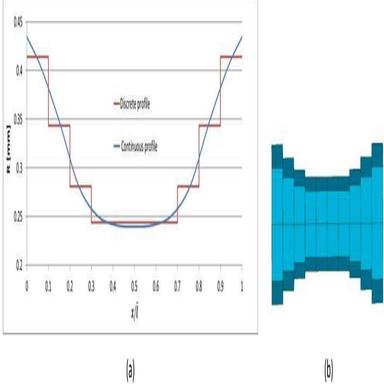
(a) Difference between the continuous and the discrete ligaments profile. (b) Ligament of the beam elements modeling.